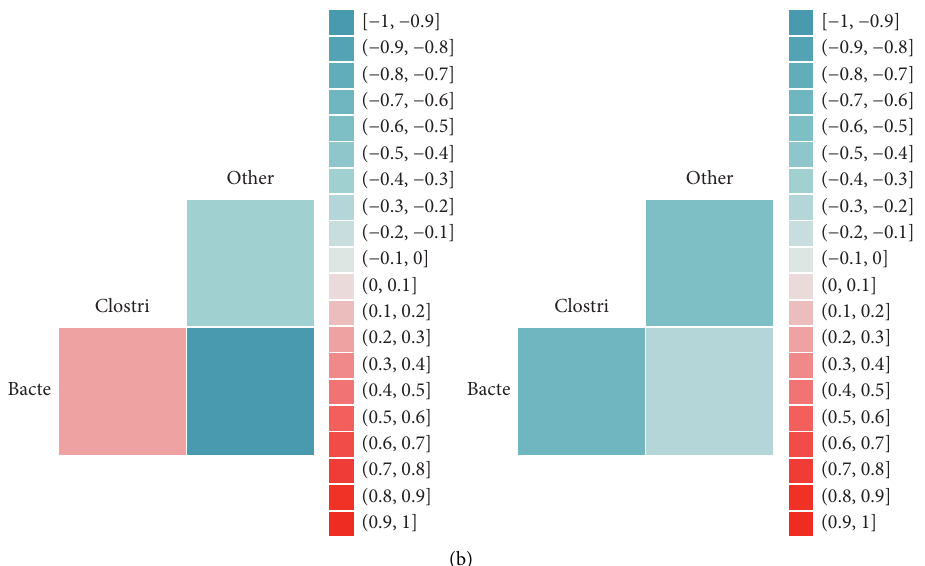
Figure 8: Correlation matrices to analyze the relationship between taxa for the subjects reported by Durb´an et al. (a) and Lloyd-Price et al. (b),